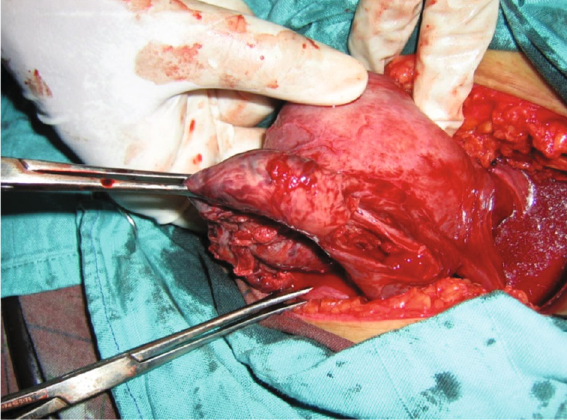
Figure 4: Ruptured rudimentary horn at the right